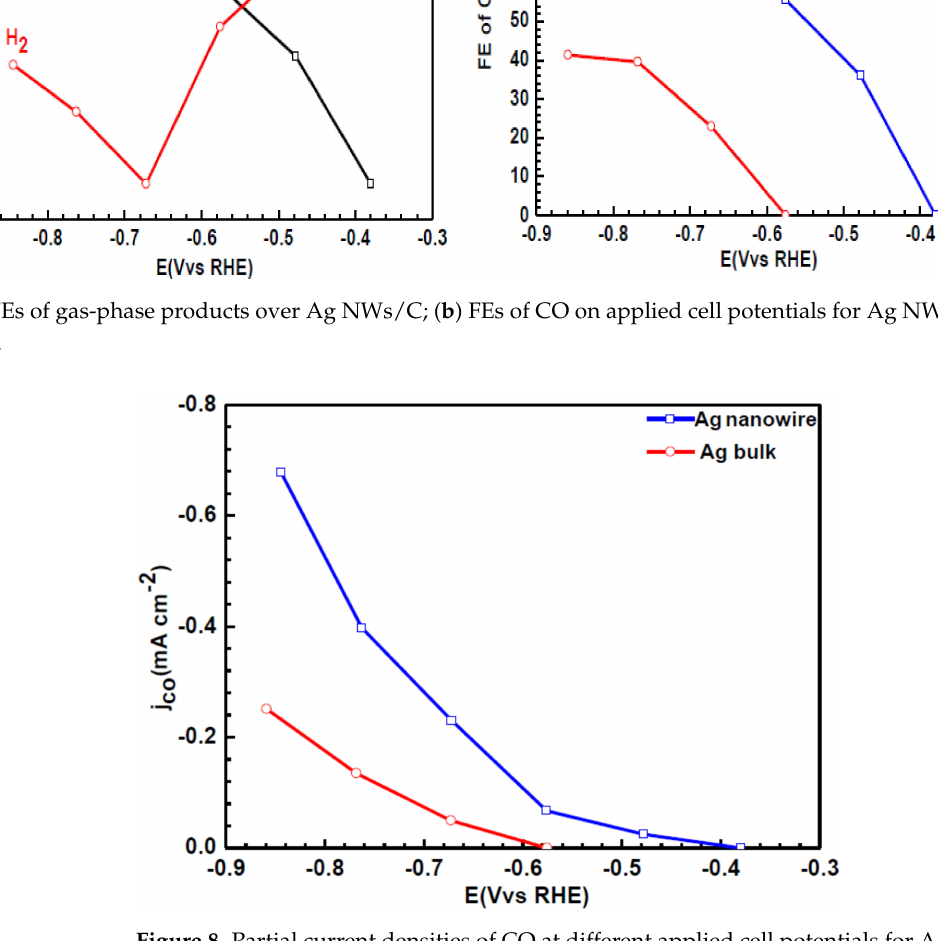
Figure 8. Partial current densities of CO at different applied cell potentials for Ag NWs/C and Ag bulk